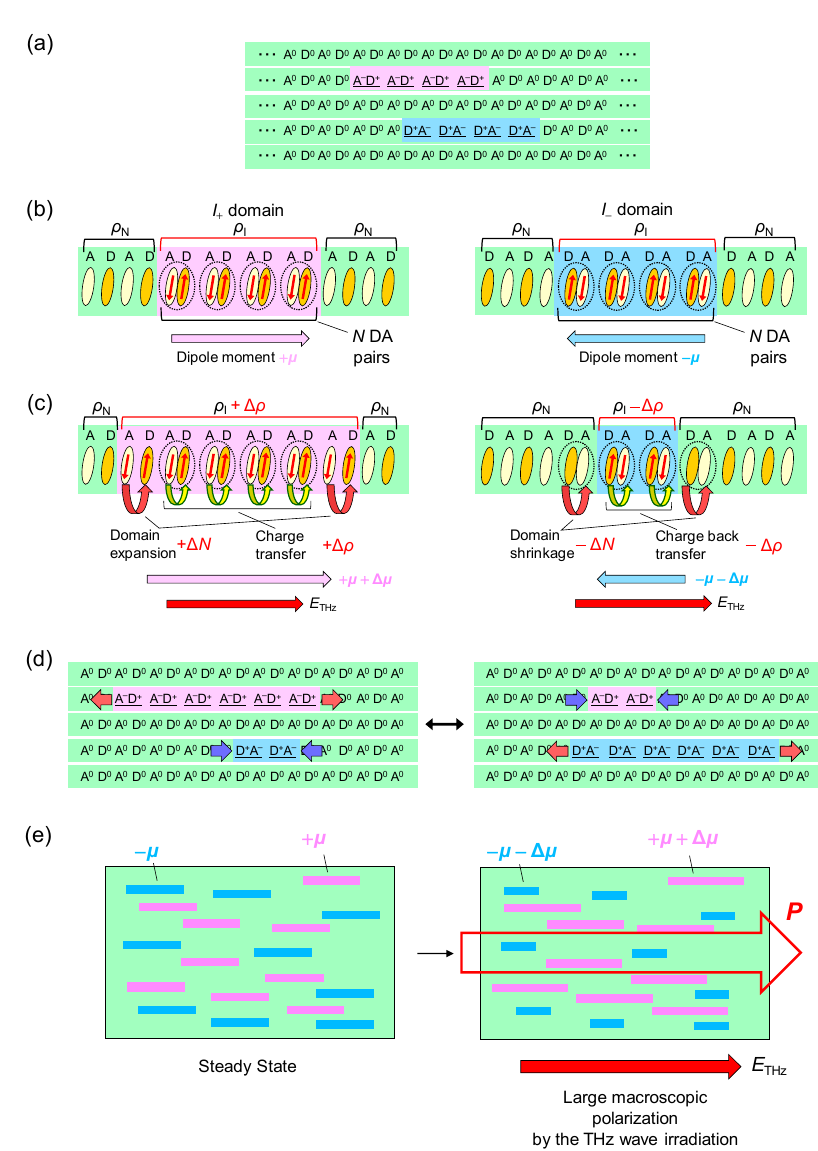
Figure 26. Schematics of observed responses to a terahertz electric-field pulse in the paraelectric neutral phase of TTF-CA [42]. ( a , b ) 1D microscopic ionic domains fluctuating in the neutral region. An I + domain has a dipole moment + μ and an I − domain has a dipole moment − μ ; ( c ) Terahertz-electric-field-induced changes of 1D ionic domains. A terahertz electric field with the right-hand direction increases (decreases) the size of an I + ( I − ) domain via intermolecular charge transfers at domain boundaries (red curved arrows) and changes ρ by Δ ρ ( −Δ ρ ) within the ionic domain (yellow curved arrows); ( d ) Coherent oscillations of NIDW pairs. ( e ) A large macroscopic polarization produced by microscopic changes of 1D ionic domains.